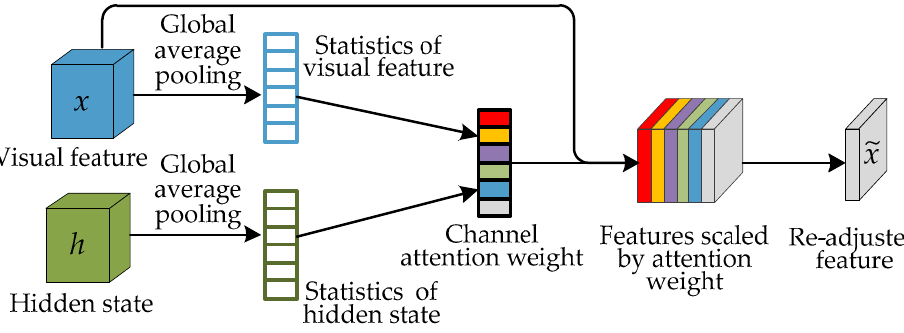
Figure 3. The channel attention mechanism for the proposed CNN-CAtt-ConvLSTM model.